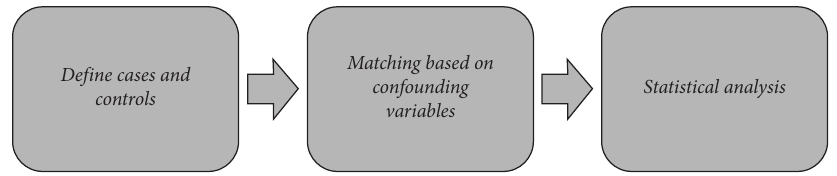
Figure 1: The three main steps of a case-control study